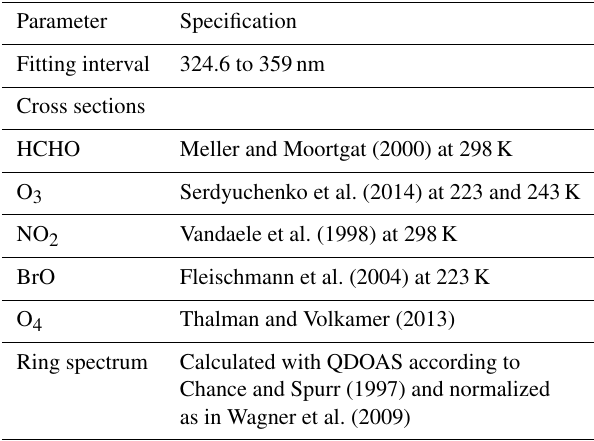
Table 1. DOAS analysis settings for HCHO slant column density